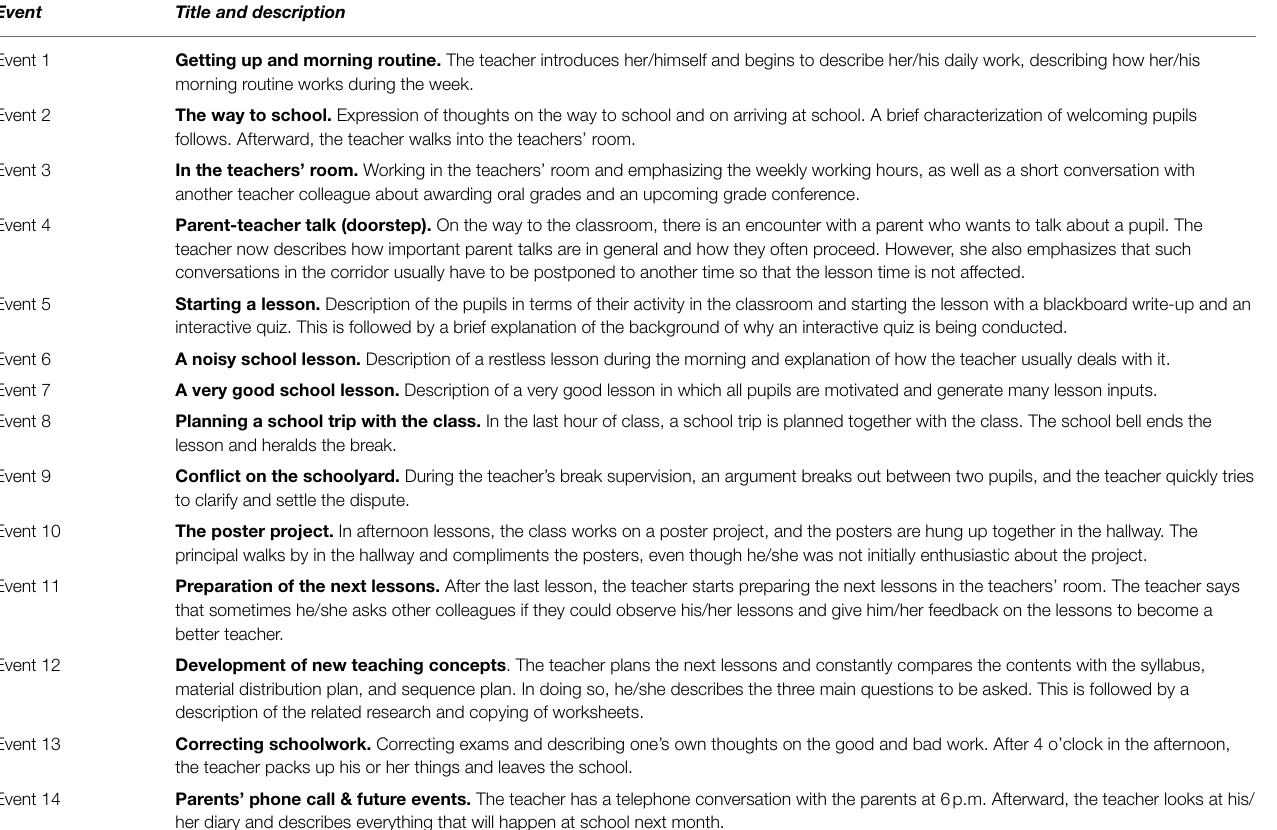
TABLE 1 | Description of the evaluated teaching-related